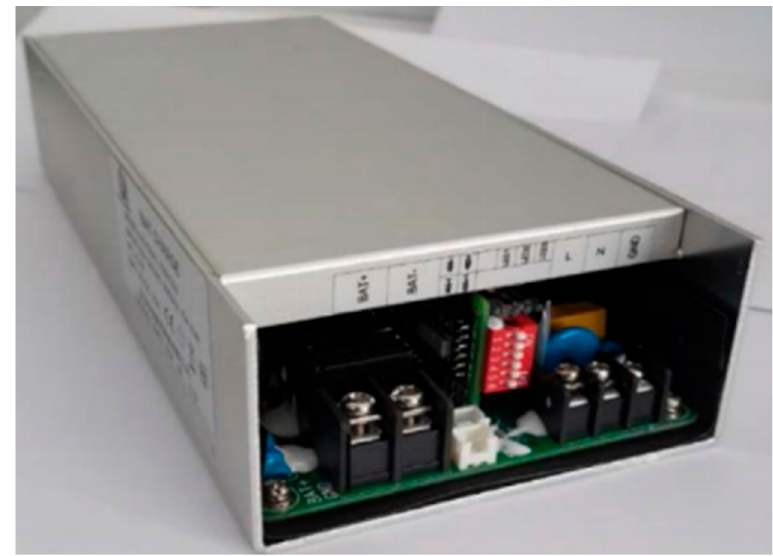
Figure 7. The battery charger